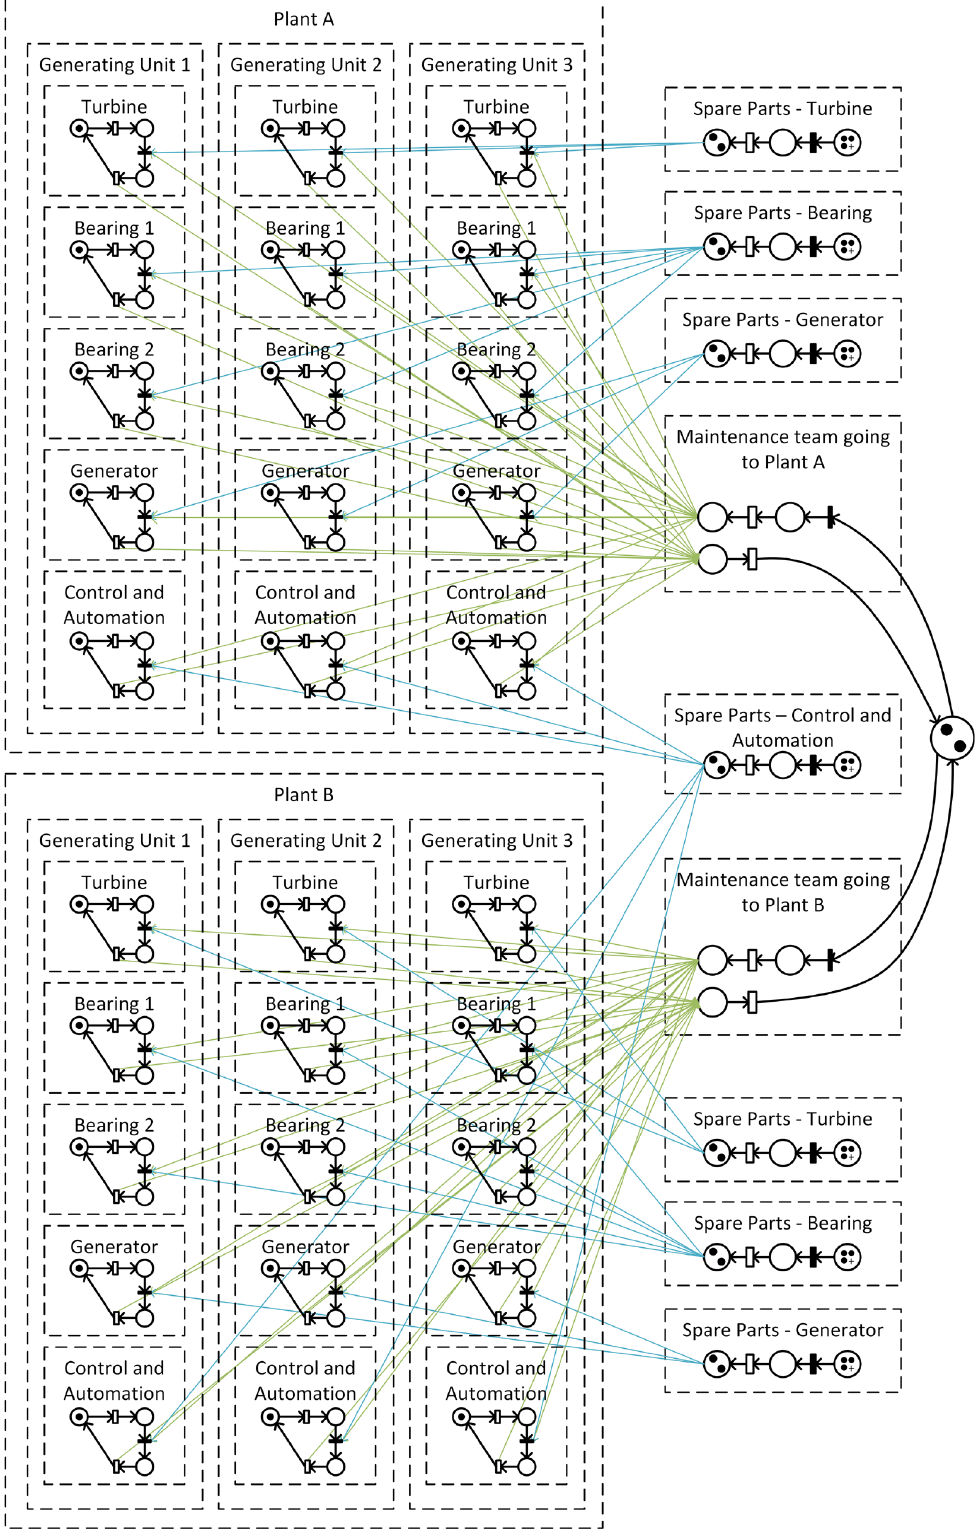
Figure 6. GSPN structure of the case study.